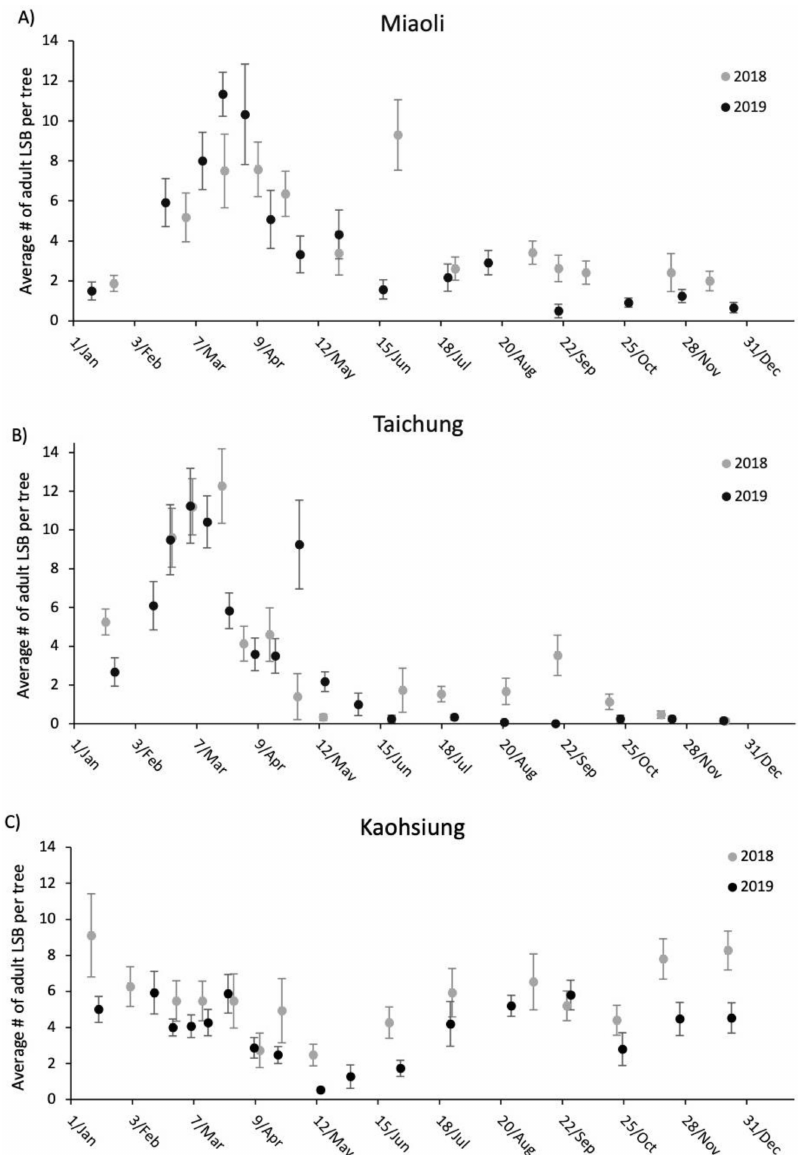
Figure 2. Dot plots with standard error bars of average number of observed adult LSB per tree from January through December at Miaoli ( A ), Taichung ( B ), and Kaohsiung ( C ), for 2018 (grey) and 2019